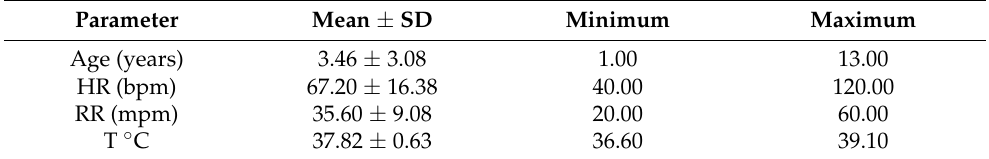
Table 1. Clinical parameters (mean, standard deviation, minimum and maximum) in Pega breed donkeys.